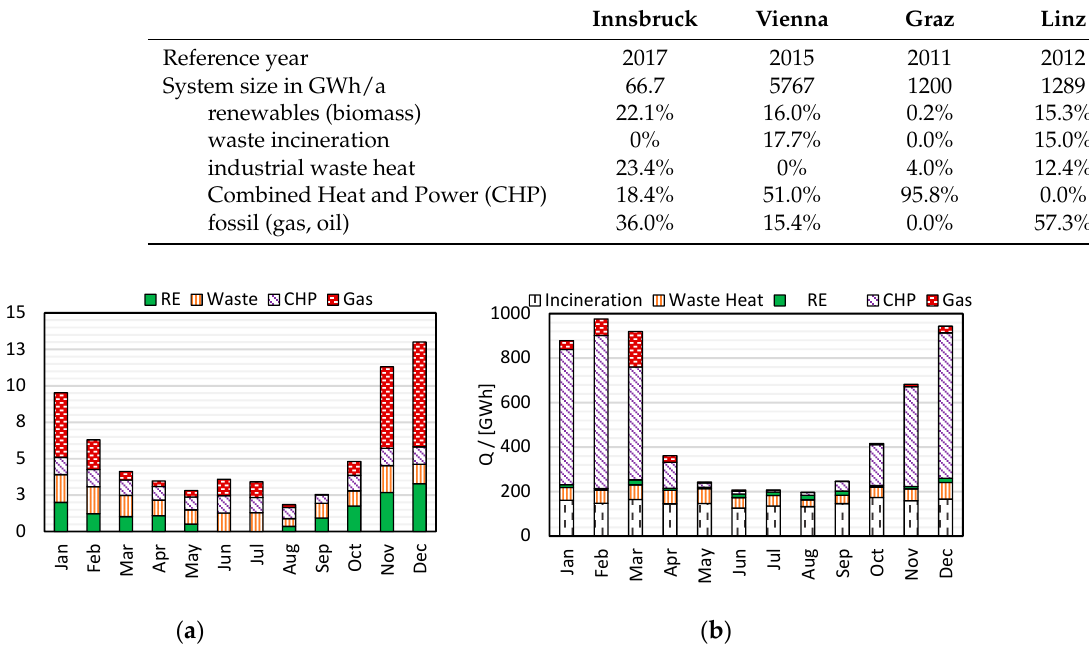
Figure 2. ( a ) District Heating (DH) in Innsbruck (monthly balance, simplified), acc. to [13]; ( b ) DH in Vienna (monthly balance, simplified) acc. to [12]; both own representation (i.e., RE: Renewables, CHP: Combined Heat and Power).